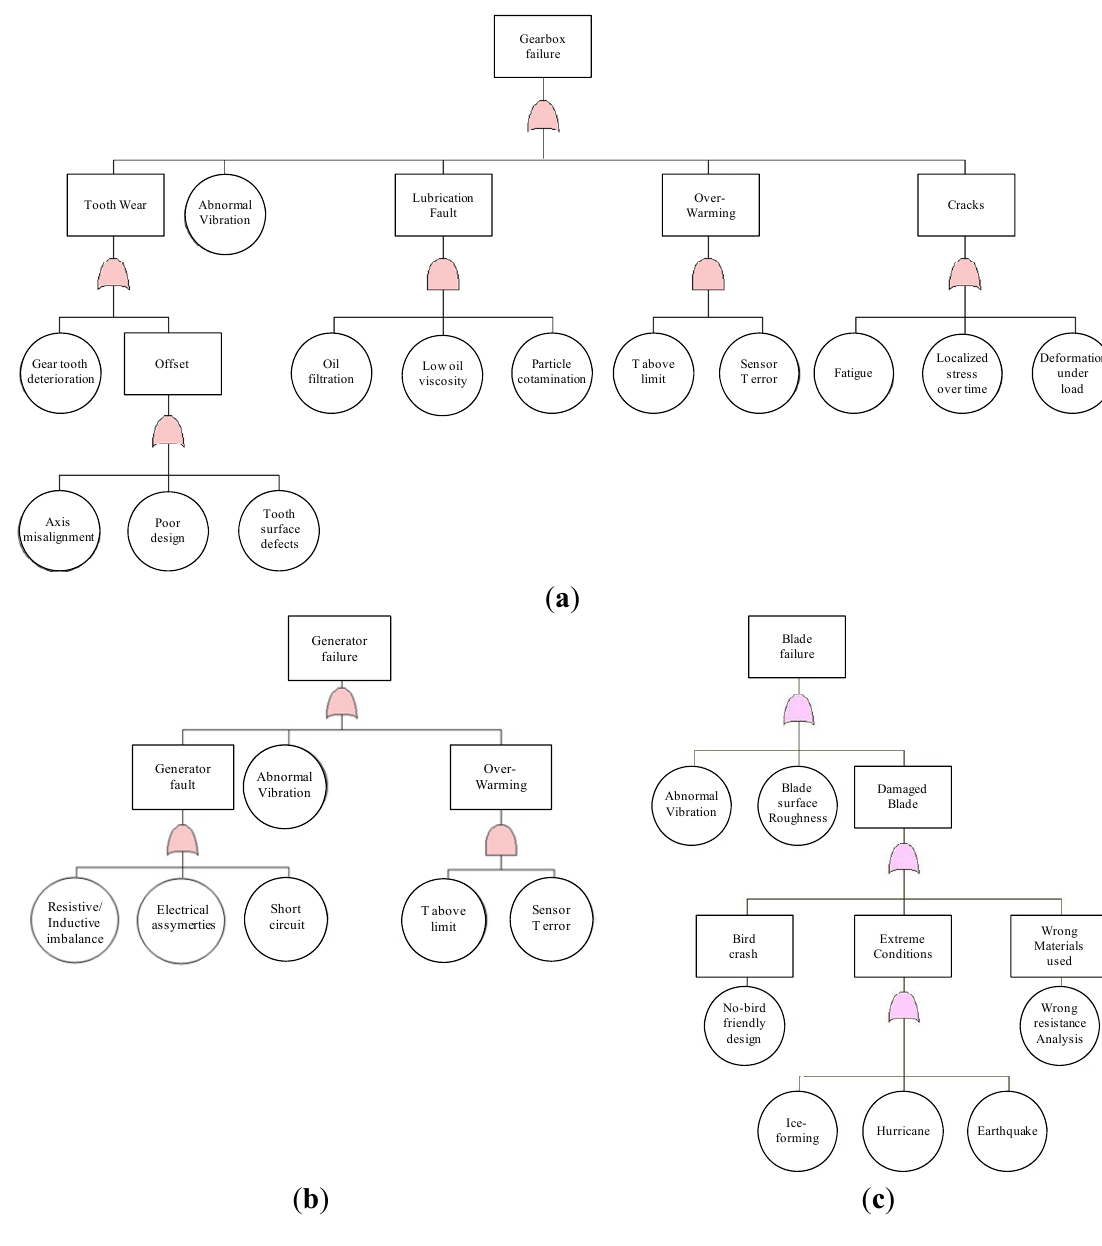
Figure 3. Fault tree diagram for ( a ) gearbox; ( b ) generator and ( c ) the